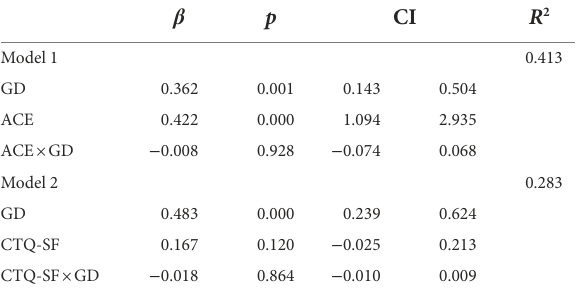
TABLE 1 Simple ordinary least squares regression testing independent and moderation effects of disinhibition, ACE, and CTQ-SF on the prediction of